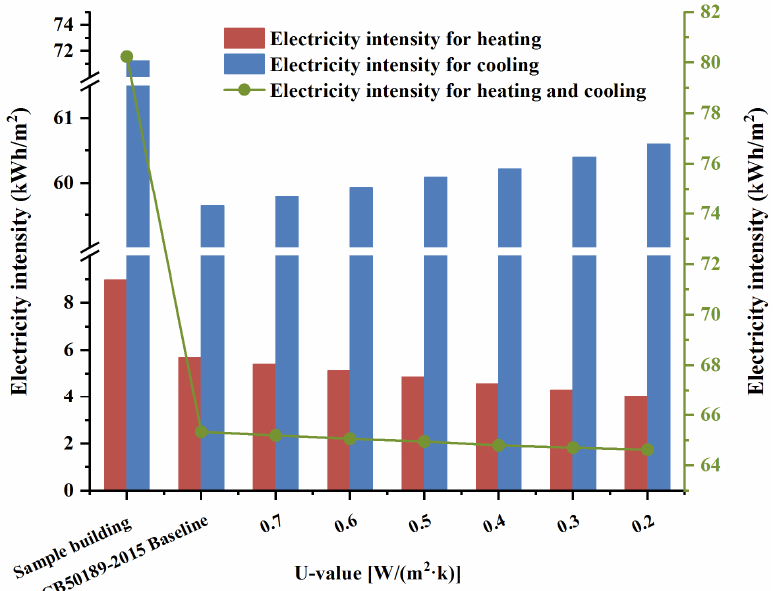
Figure 6. Electricity intensity for heating and cooling using different U-values for external wall energy retrofitting.